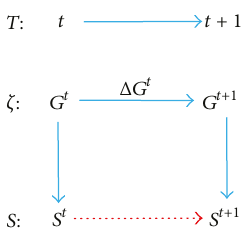
Figure 4: IncInf